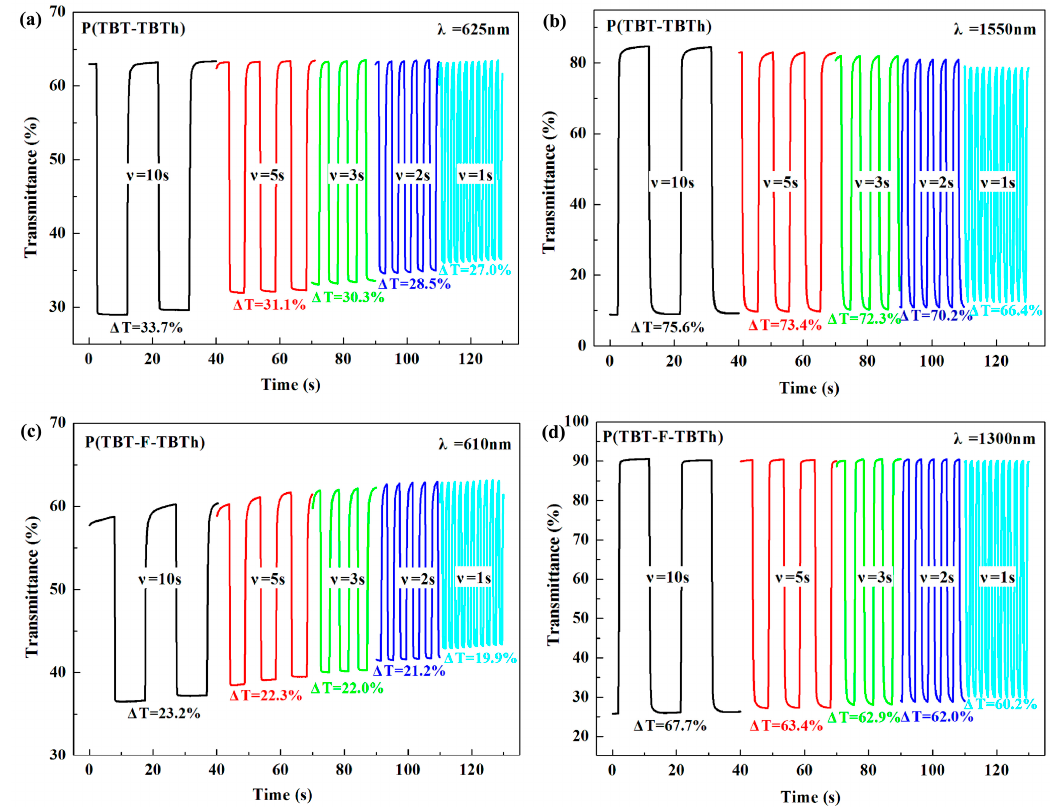
Figure 9. Electrochromic switching of the polymer films with different intervals: (a) P(TBT-TBTh) monitored at 625 nm; (b) P(TBT-TBTh) monitored at 1550 nm; (c) P(TBT-F-TBTh) monitored at 610 monitored at 625 nm; ( b ) P(TBT-TBTh) monitored at 1550 nm; ( c ) P(TBT-F-TBTh) monitored at 610 nm; nm; (d) P(TBT-F-TBTh) monitored at 1300 nm. ( d ) P(TBT-F-TBTh) monitored at 1300